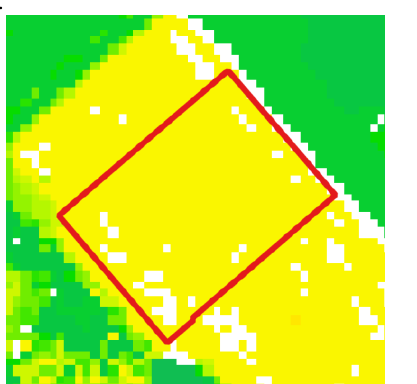
Figure 6. A building model (red) overlaid on the rasterized AHN3 (cellsize 0,5m, colour gradient by height where green is low, yellow is high elevation, missing data is white). In case of this particular model, the yellow cells are classified as “building”, the green cells are classified as “ground” in AHN3. In an earlier version, also points were missing since AHN3 tiles were not yet completely covered (which was not documented).